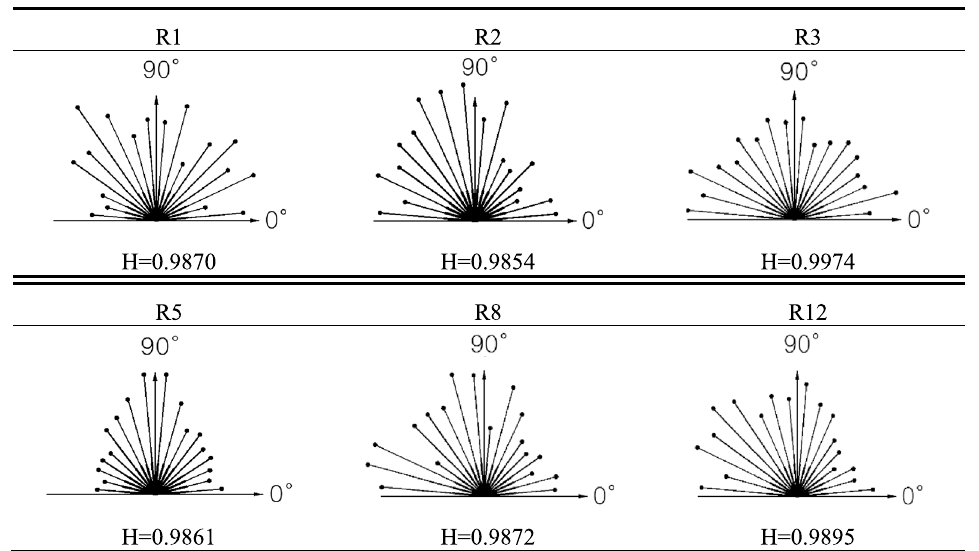
Table 5. Probability entropy of red-bed soft rock in different water–rock interaction cycles.